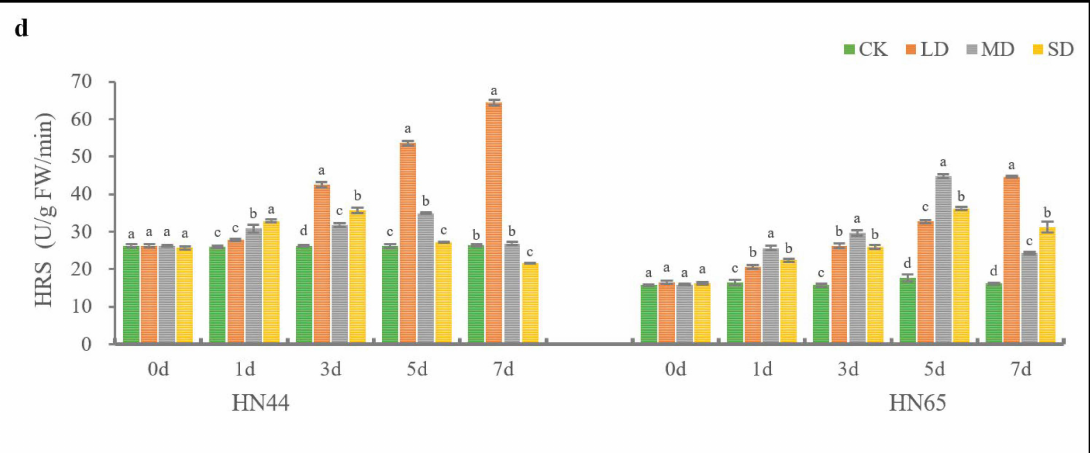
Figure 4. Changes in MDA ( a ), T-AOC ( b ), SASC ( c ), and HRS ( d ) over time in HN44 and HN65 under different drought degrees. Different letters in treatments indicate significant differences according to Duncan’s single factor variance test at the 5% level, and data are presented as mean ± SE (standard error) ( n =